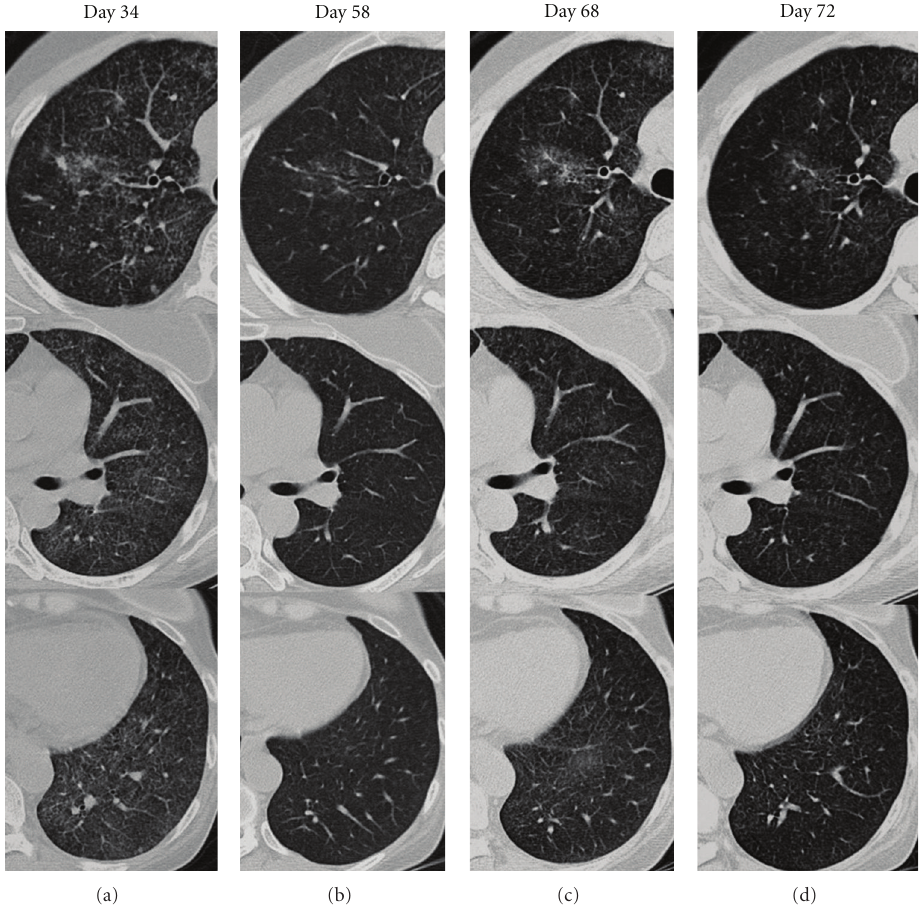
Figure 4: CT findings. (a) On day 34, miliary nodules were seen in both lung fields, but interstitial shadows were ameliorated. (b) On day 58, miliary nodules had almost disappeared from both lung fields. (c) On day 68, new shadowing appeared in both upper lobes. (d) Sickly shadowing had disappeared by day